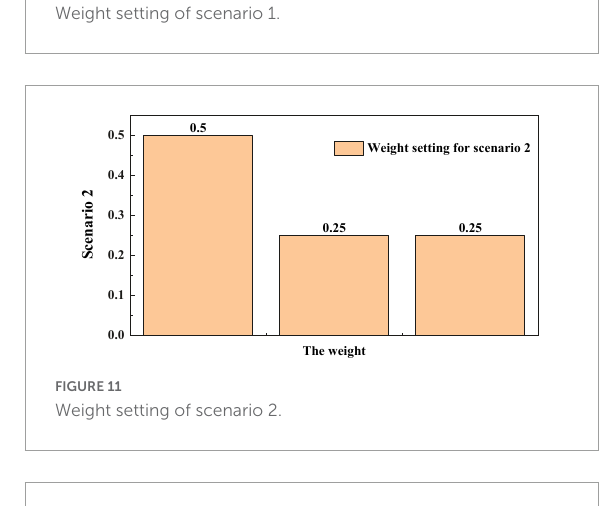
FIGURE10 Weight setting of scenario 1.